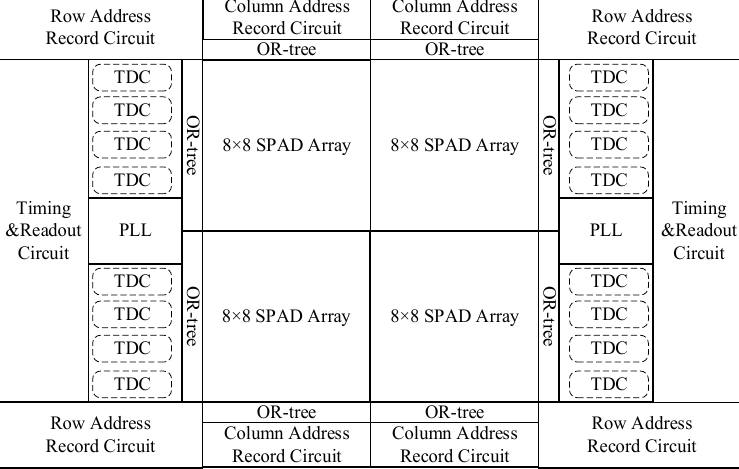
Figure 1. Circuit architecture.